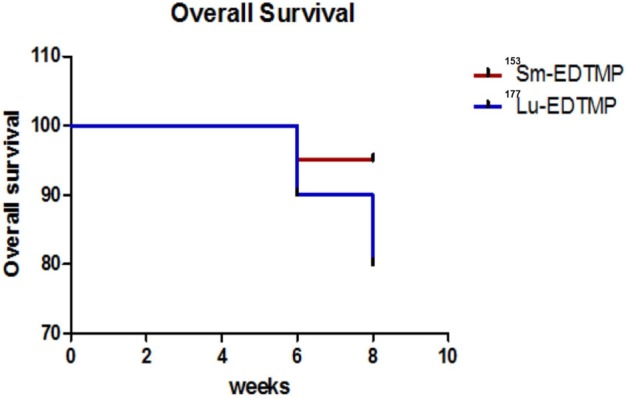
Kaplan–Meier survival curve in patients treated with 153Sm-EDTMP and 177Lu-EDTMP.